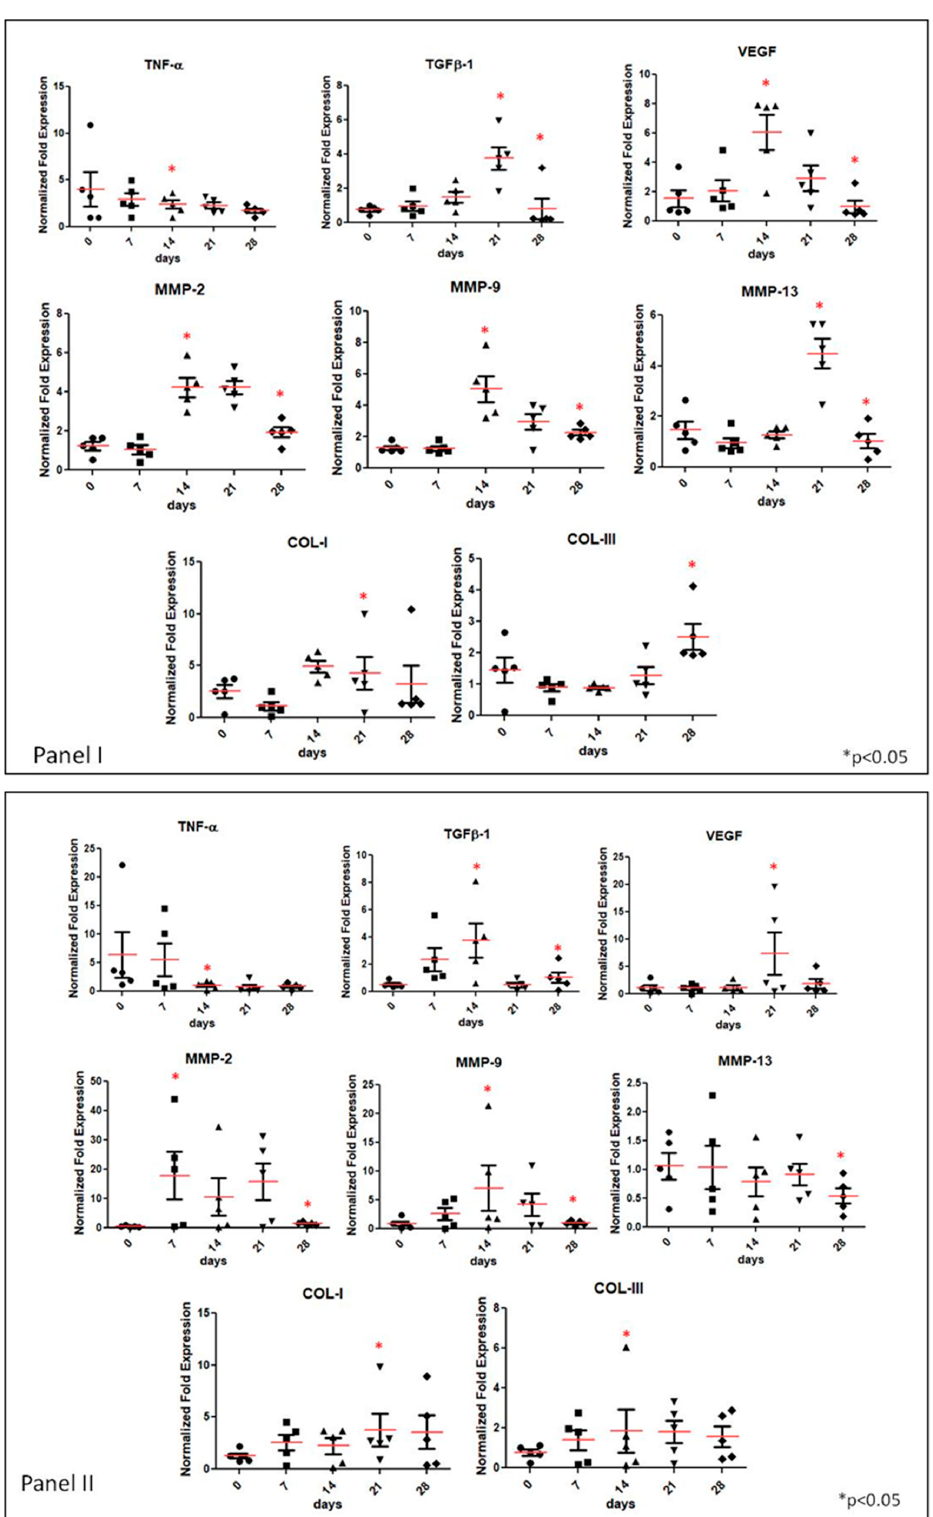
Figure 5. Gene expression profile provided by qRT-PCR on IDRT- and IFWM-treated lesions. Each of them is normalized with respect to its expression in the healthy tissue of the patient before treatment. ( Panel I ) Gene expression analyses carried-out by qRT-PCR, on TNF- α , TGF β -1, VEGF, MMP 2–9 and 13, COL-I and COL-III in IDRT-treated lesions. Student t -test analyses were performed using graph-pad software and we compared two time groups as follows: TNF- α at 14